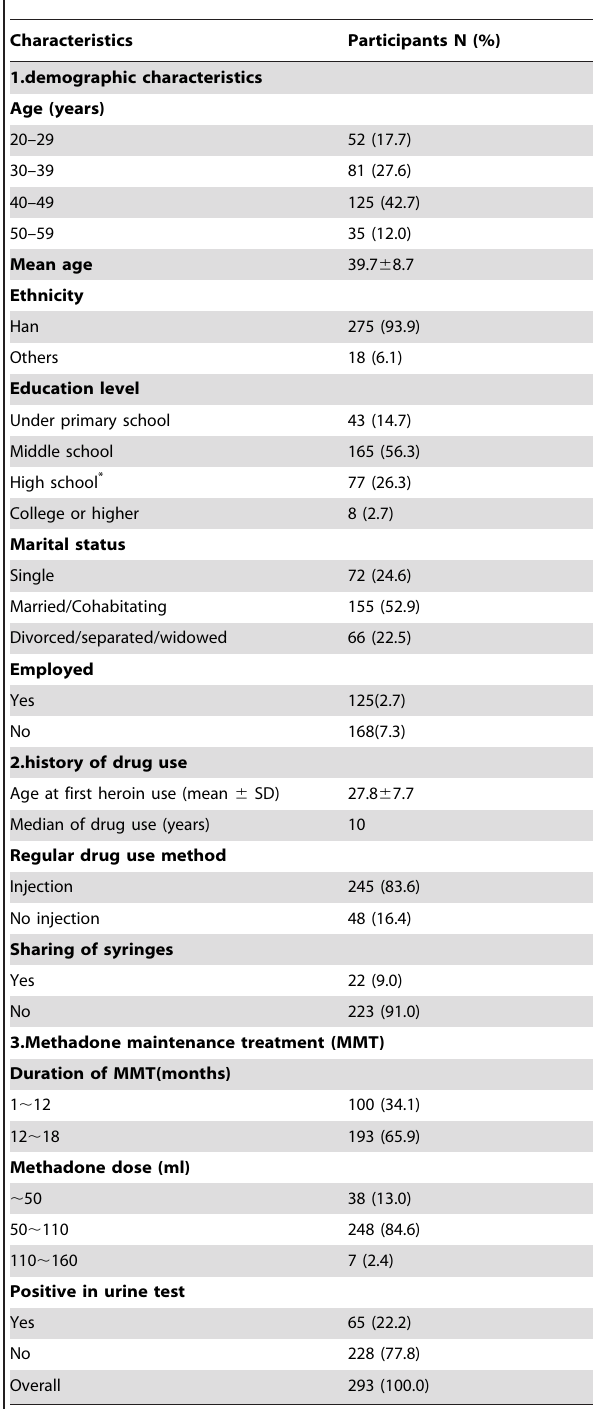
Table 1. Demographic and self-reported heroin use characteristics of